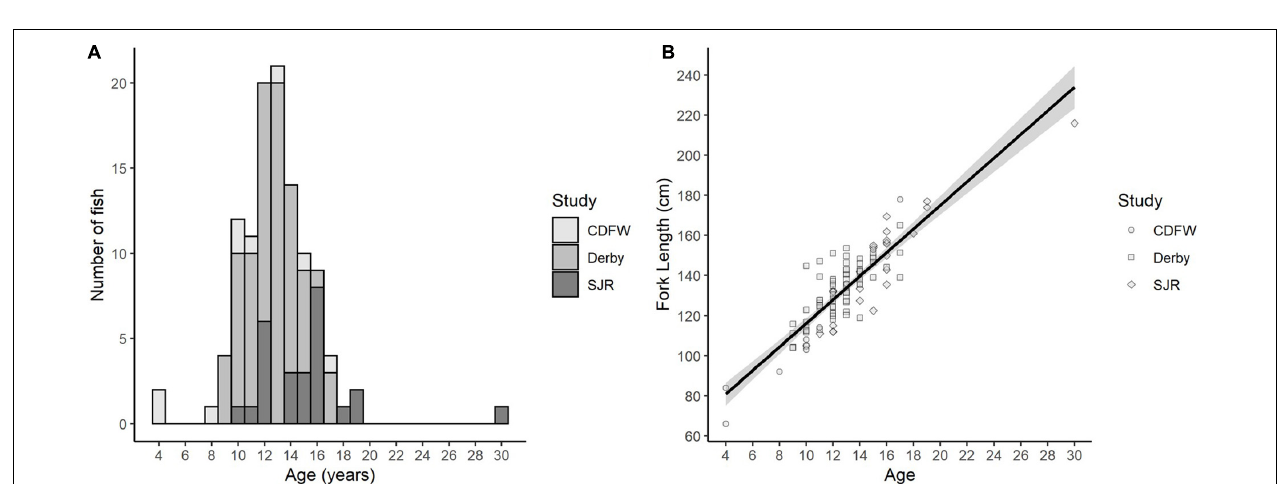
FIGURE 4 | (A) Histogram of number of fish in each age bin, and (B) fork length to fish age relationship ( R 2 = 0.77). Study designates the origin of the samples collected from the California Department of Fish and Wildlife (CDFW) trawling surveys, sturgeon sport fishing derbies (Derby), or the San Joaquin River (SJR) gill and trammel net